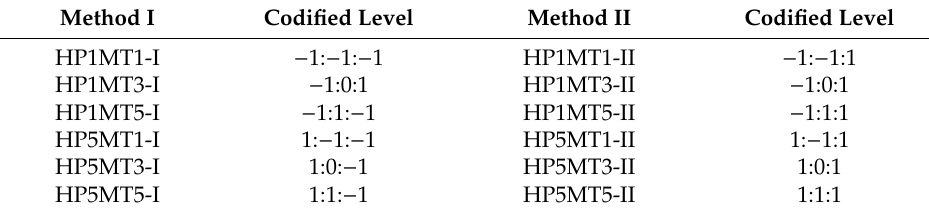
Table 5. Design of experiments with codified factor levels for the full factorial